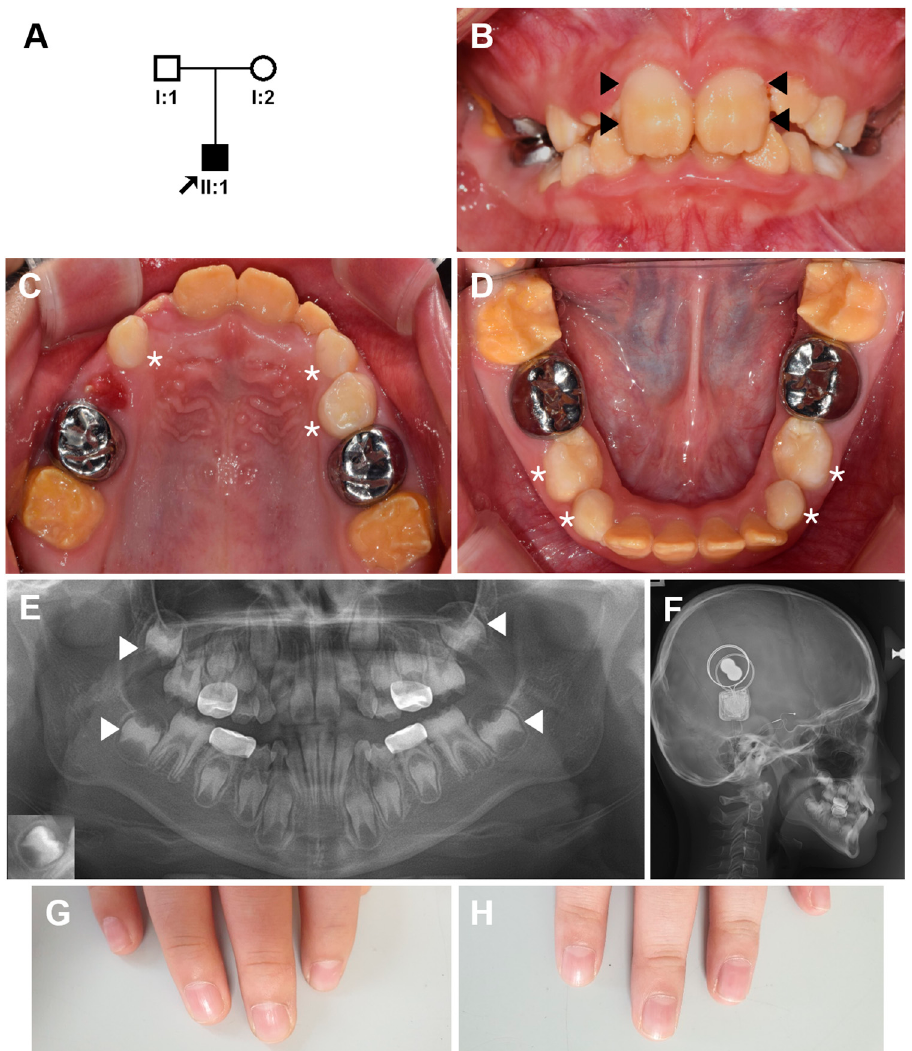
Figure 1. Pedigree, clinical photos, and radiographs of the proband. ( A ) Pedigree of the family. The arrow indicates the proband, and individual IDs are shown below the symbols. ( B – D ) Frontal, maxillary and mandibular clinical photos of the proband at age 8 years 7 months. The buccal side of the maxillary central incisors shows relatively normal looking areas in the middle and cervical thirds (black arrow heads). Deciduous teeth (white asterisks) do not have hypoplastic enamel or discoloration, but the permanent teeth show hypoplastic enamel and brown discoloration. ( E ) A panoramic radiograph revealed hypoplastic enamel in the developing permanent dentition. Almost no covering enamel can be easily seen in the second molars (white arrow heads) compared to the normal tooth in an inset at the lower left corner. ( F ) Bilateral cochlear implants can be seen in the lateral cephalogram. ( G , H ) His finger nails are normal.